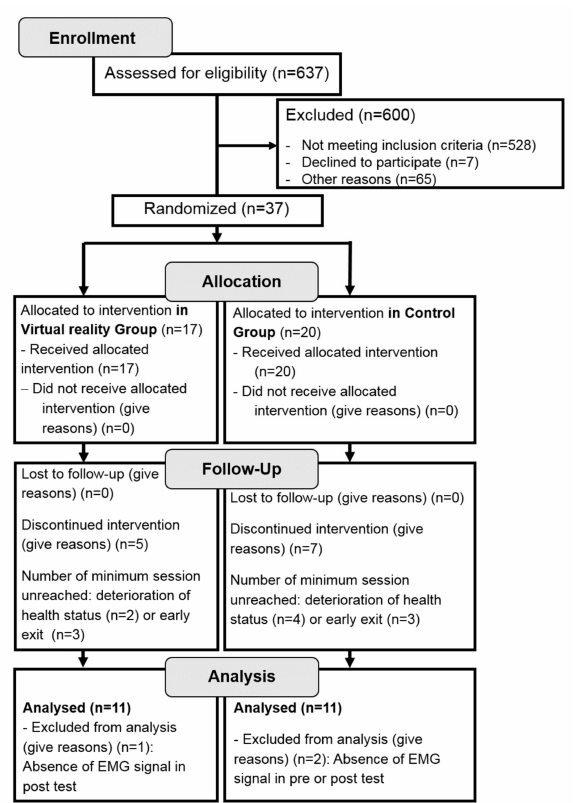
Figure 1. CONSORT flow chart of the